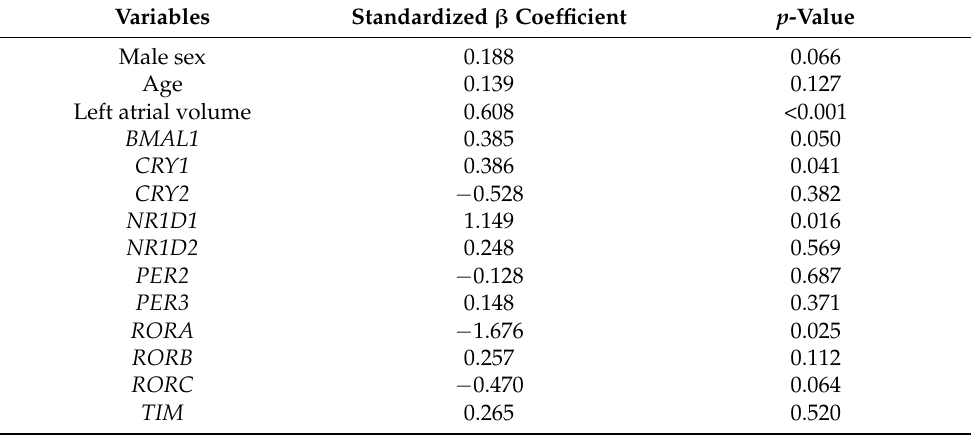
Table 3. Multiple linear regression model predicting burden of atrial high-rate